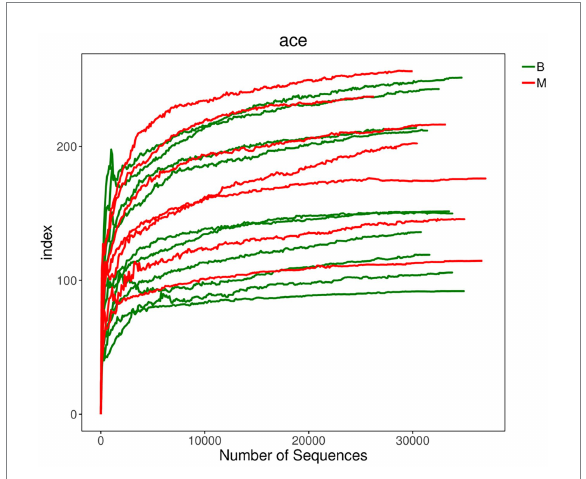
FIGURE 1 Comparison of α -diversity between Group M and Group B. ACE index dilution curve chart. There was no significant difference in α -diversity between the two groups.